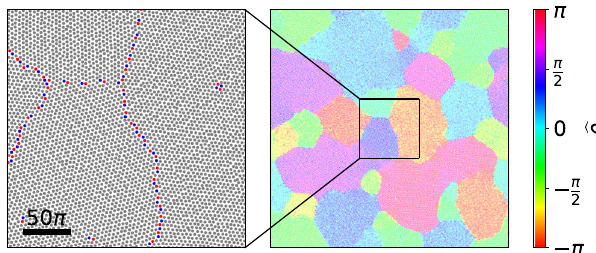
Fig. 7 AVL consisting of domains with different lattice orientations (right), obtained from a simulation with α = − 0.9 and λ = 15, following the standard upscaling process described in the Methods. The zoom-in shows the defects between the domains (left). Fig. 8 Analysis of melting of AVL domains. Top row shows the vorticity